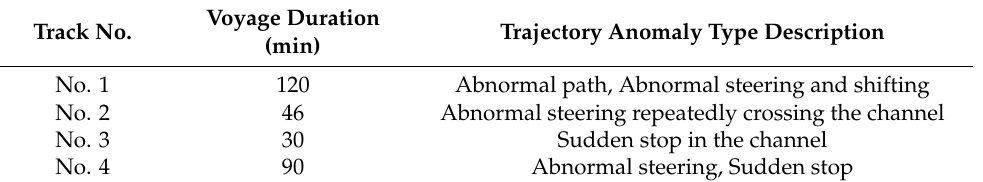
Figure 19. Anomaly detection experiment trajectories. Table 10. Description of experimental trajectory.